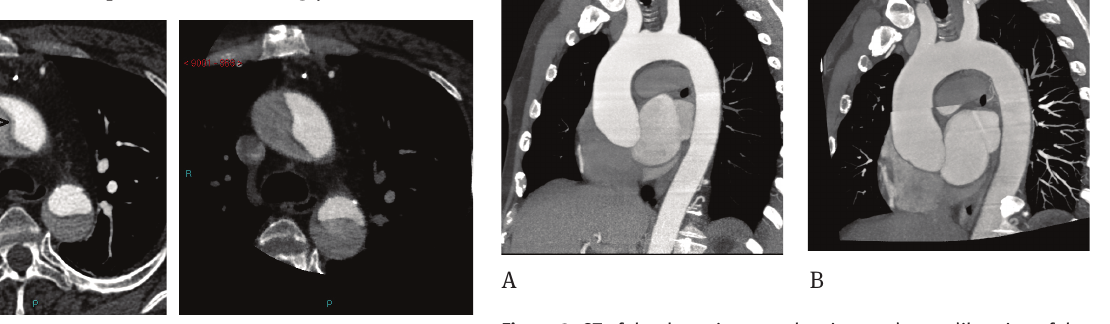
Figure 3: CT of the thoracic aorta showing moderate dilatation of the ascending aorta. The same patient was studied with the retrospec- tive gated technique with a 320 row-detector, the effective dose was 919 mGy (A). Step and shoot technique used at follow up was able to spare dose (DLP 425 mGy) but misalignment artifacts are evident at the ascending aorta